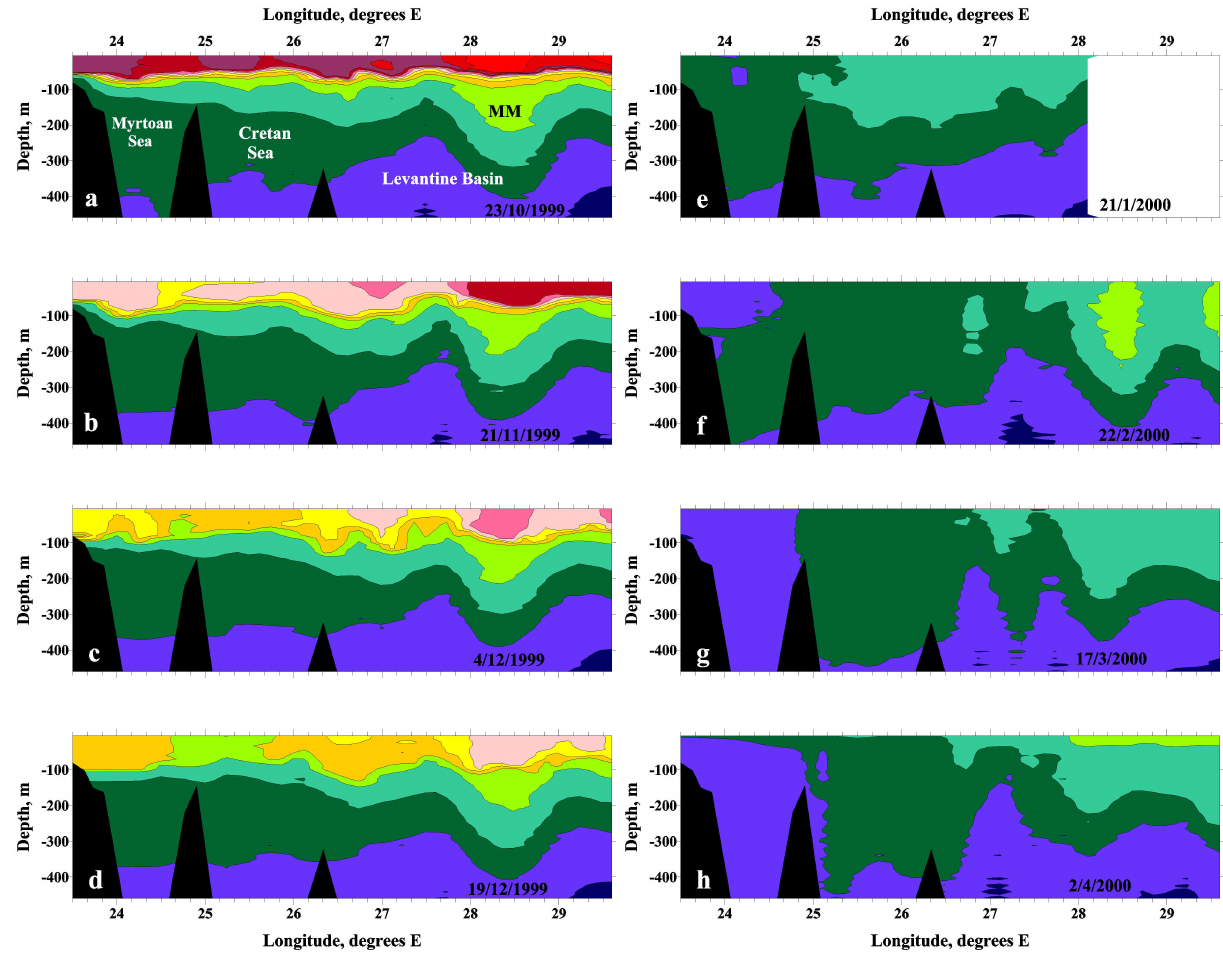
Fig. 3. Contours of temperature along the Piraeus to Alexandria transect.